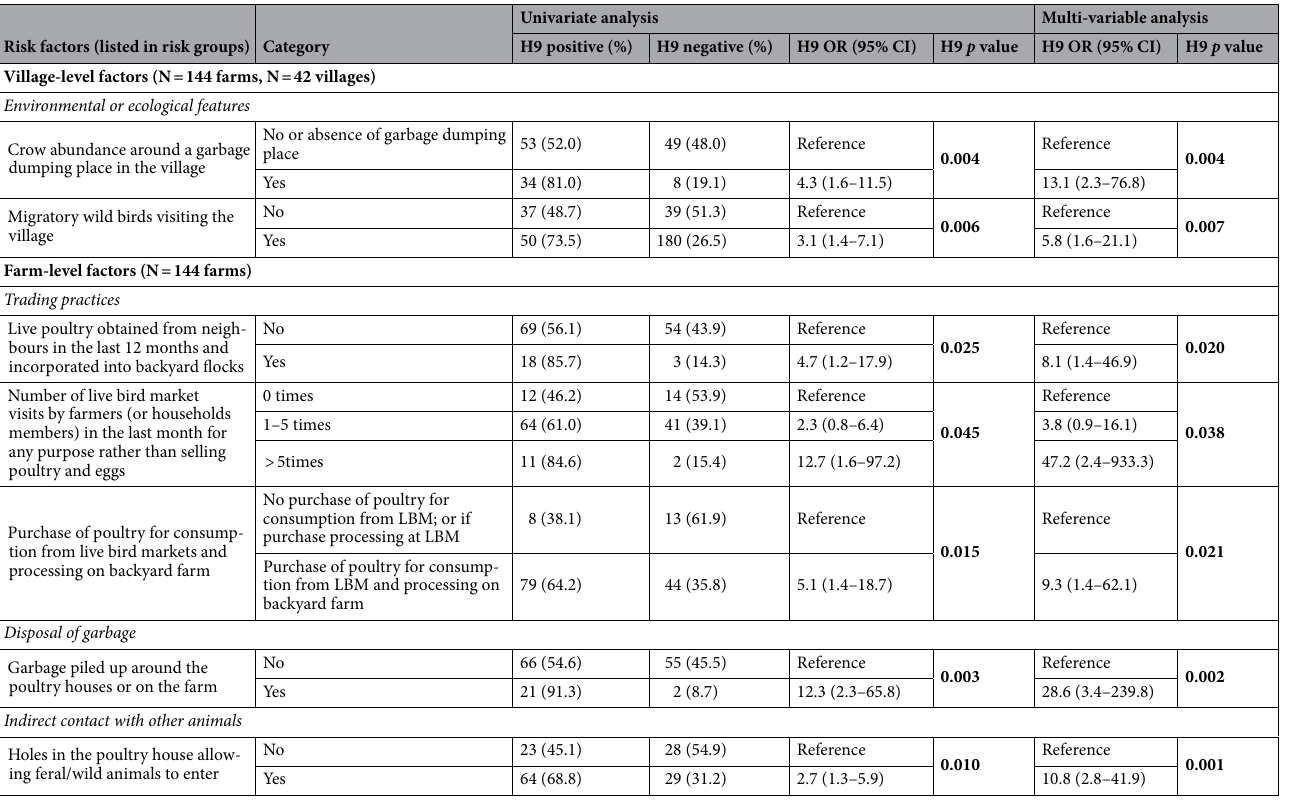
Table 2. Results of the univariate and multi-variable analysis for village and farm-level risk factors (N = 144 farms, N = 42 villages) associated with H9 flock-level seroprevalence on backyard chicken farms in Bangladesh, 2016. Significant values are in